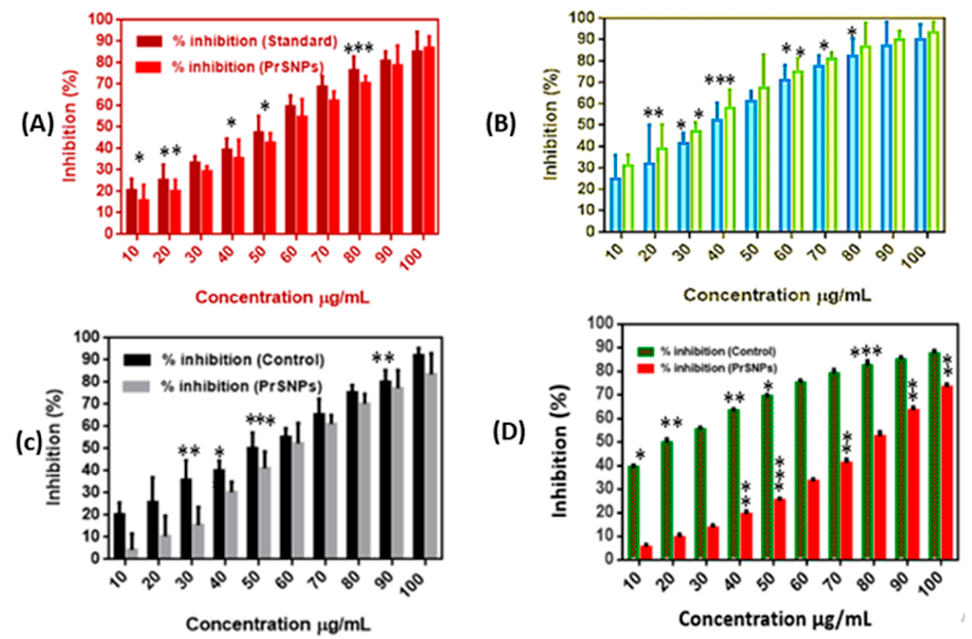
Figure 7. Anti-inflammatory activity of PrSNPs: ( A ) antioxidant activity of PrSNPs by DPPH assay ( B ) H 2 O 2 assay ( C ) NO free radical and ( D ) nitric oxide radical scavenging assay ( n = 3). All experiments performed in triplicate. * p < 0.05, ** p < 0.01 and *** p < 0.001, unpaired Student’s t-test.